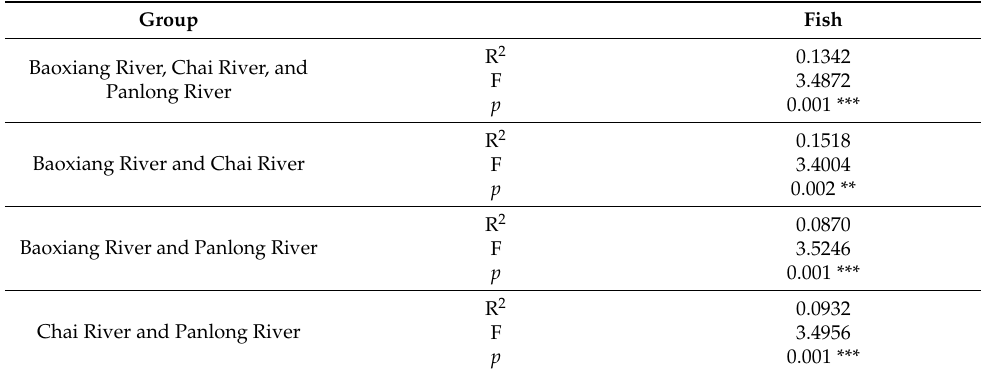
Table 2. PERMANOVA test results of the three inflowing rivers in Dianchi Lake basin.